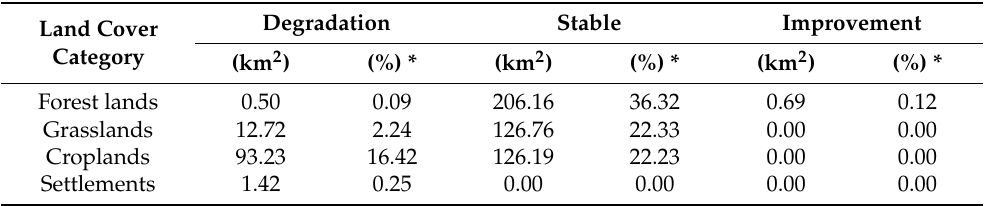
Table 6. Land Cover and state of degradation in Ixtacamaxtitlan,